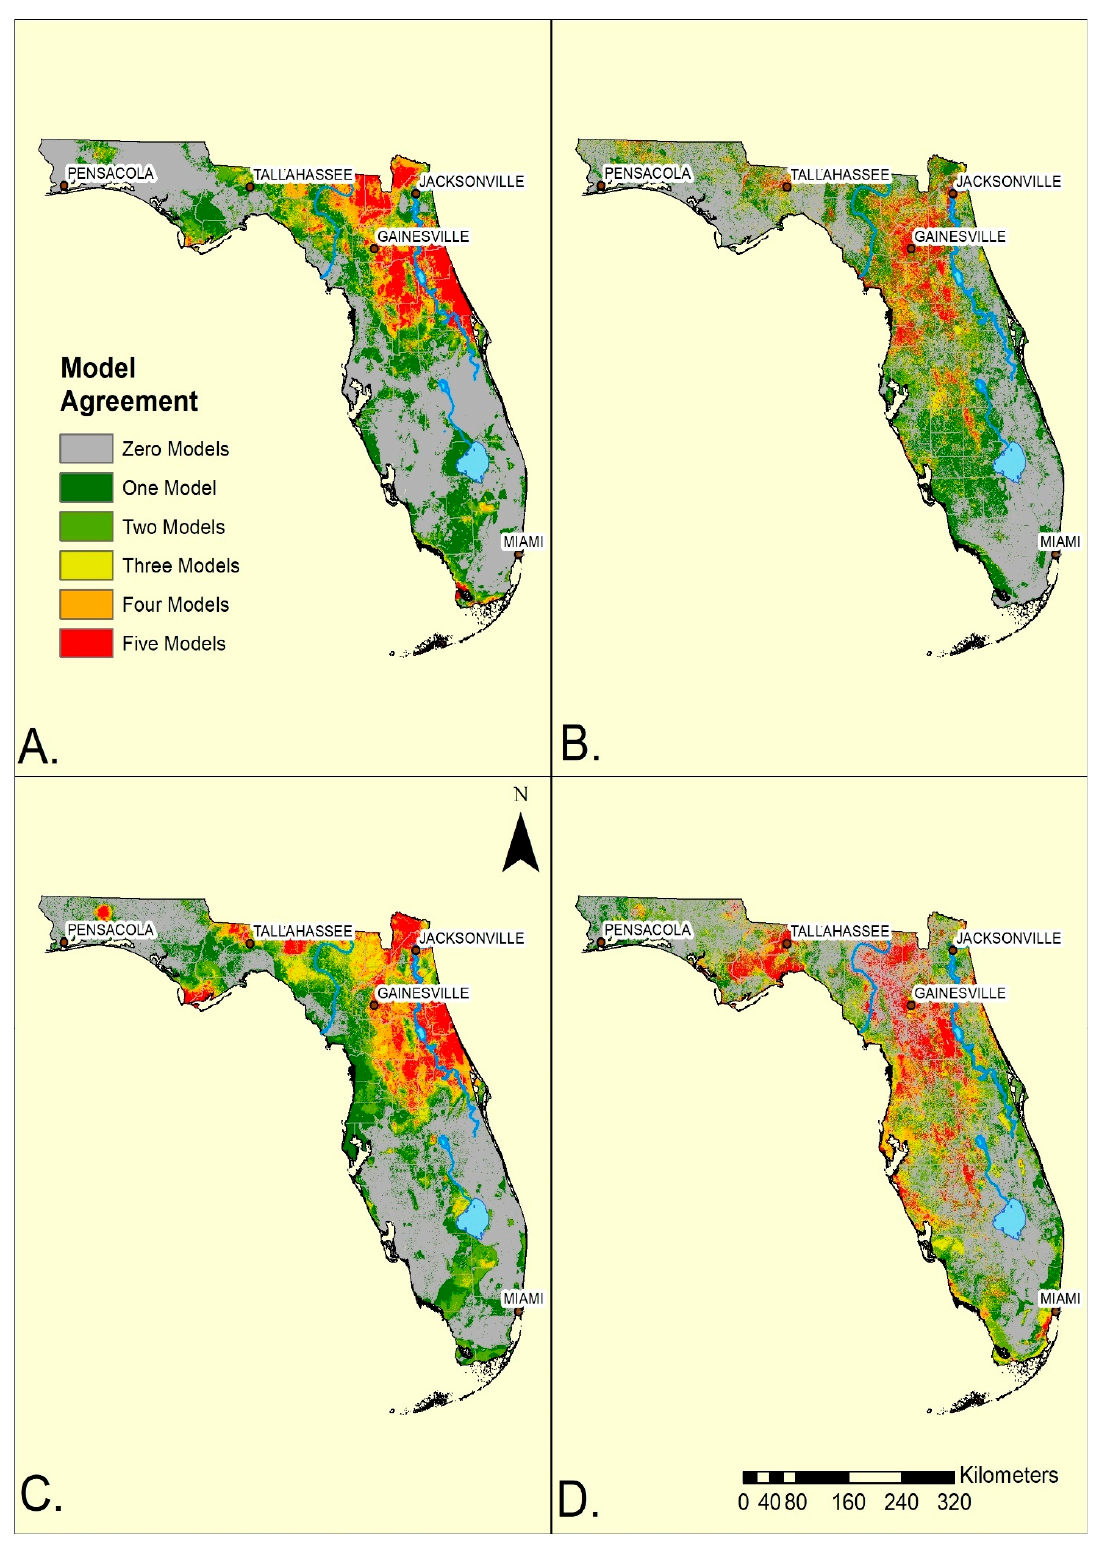
Figure 2. Ensemble models of A. americanum occurrence within Florida using standard survey ( A ), and A. americanum occurrence using convenience sampling ( B ). Ensemble models of I. scapularis occurrence within Florida using standard survey ( C ) and I. scapularis using convenience sampling ( D ). There was only slight agreement of ensemble maps, as measured by Kappa, for A. americanum , (Kappa = 0.016; Maps ( A , B )) and for I scapularis (Kappa = 0.012; Maps ( C , D